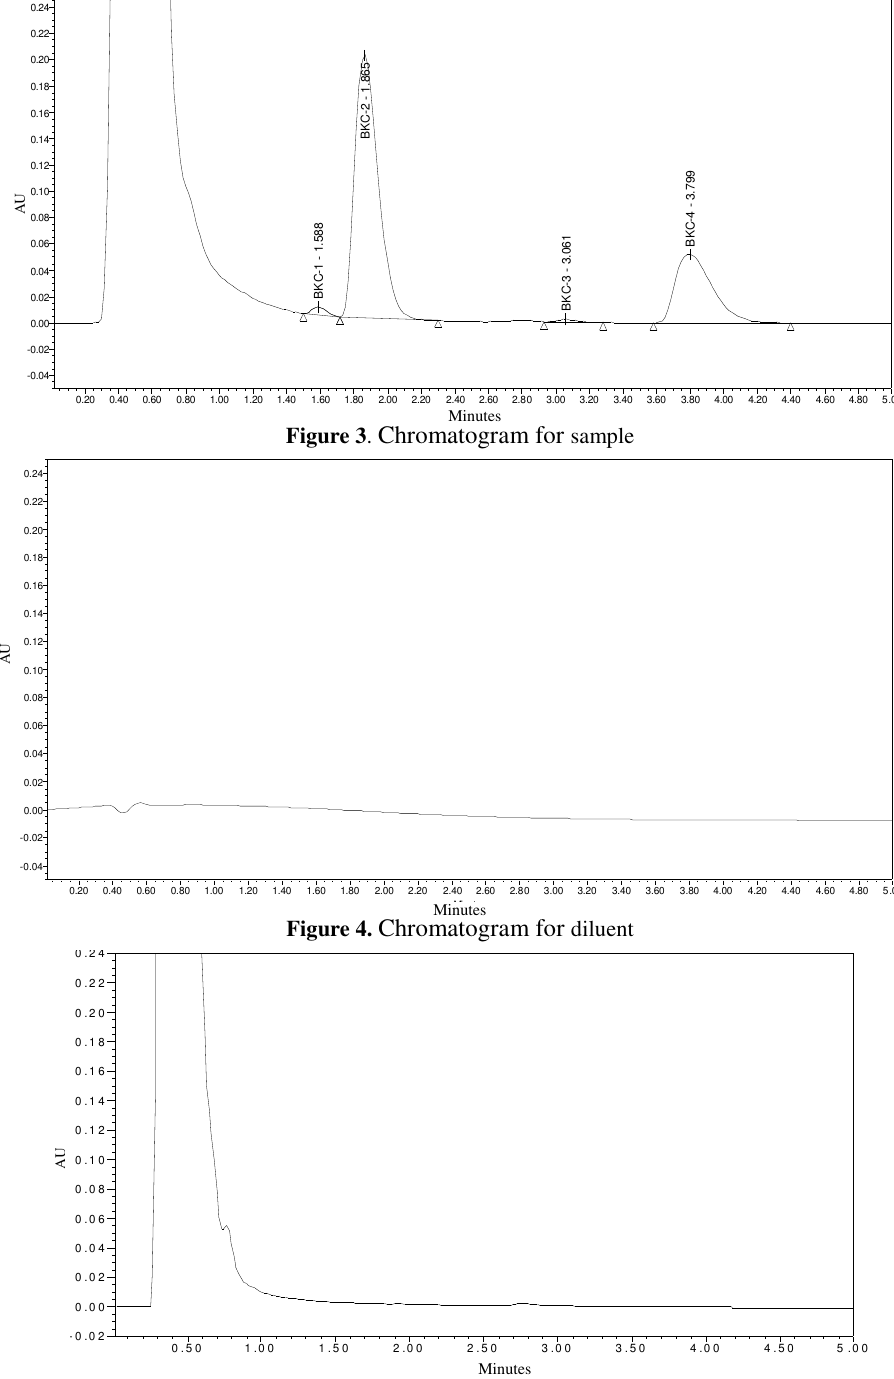
Figure 5. Chromatogram for placebo